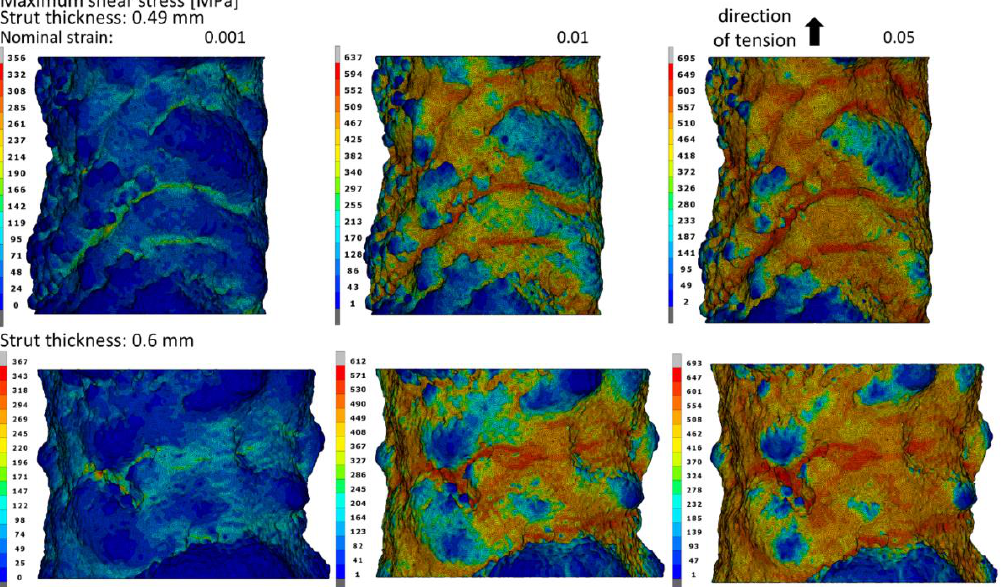
Figure 11. Maximum shear stress fields on the struts ’ surfaces with micropores at the moment of obtaining the nominal strains of 0.001, 0.01, and 0.05.